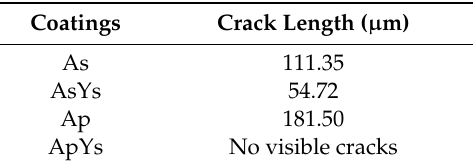
Table 3. Indentation crack length in the